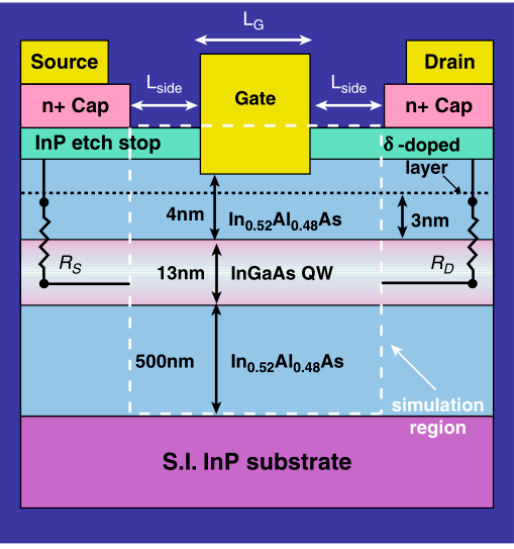
Figure 50. Critical issues of Ge / III-V integration with Si CMOS platform [344].